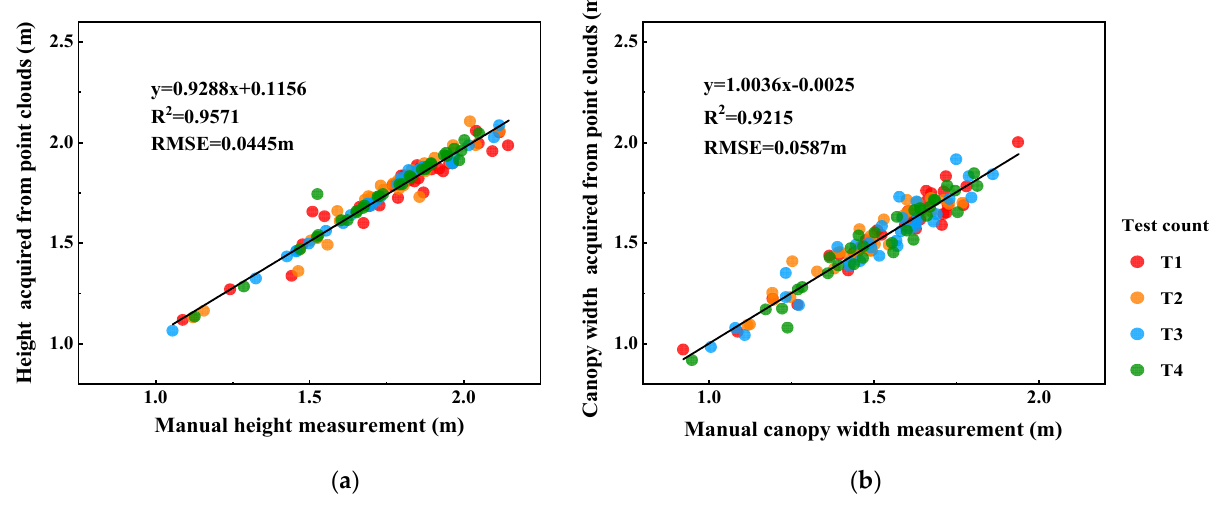
Figure 14. Scatter plot of manual measurements and point cloud data: ( a ) Height acquired from point clouds vs. manual height measurement; ( b ) Canopy width acquired from point clouds vs. manual canopy width measurement.